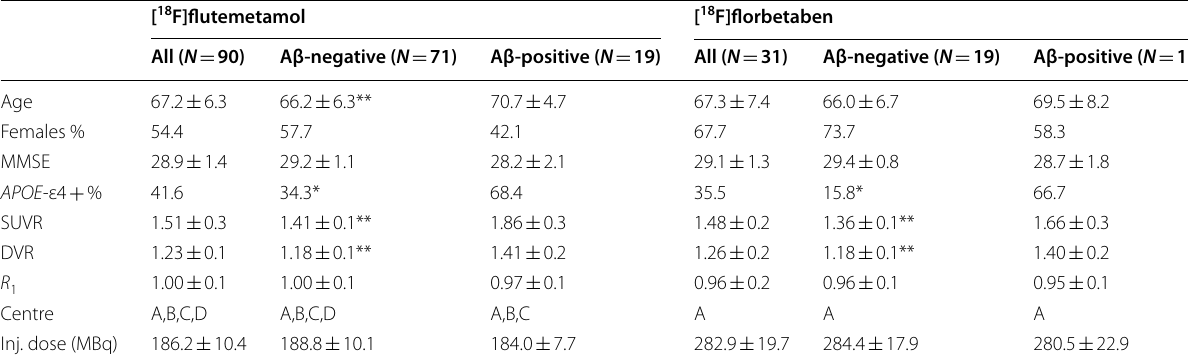
Values depicted as mean A Amsterdam UMC, B =